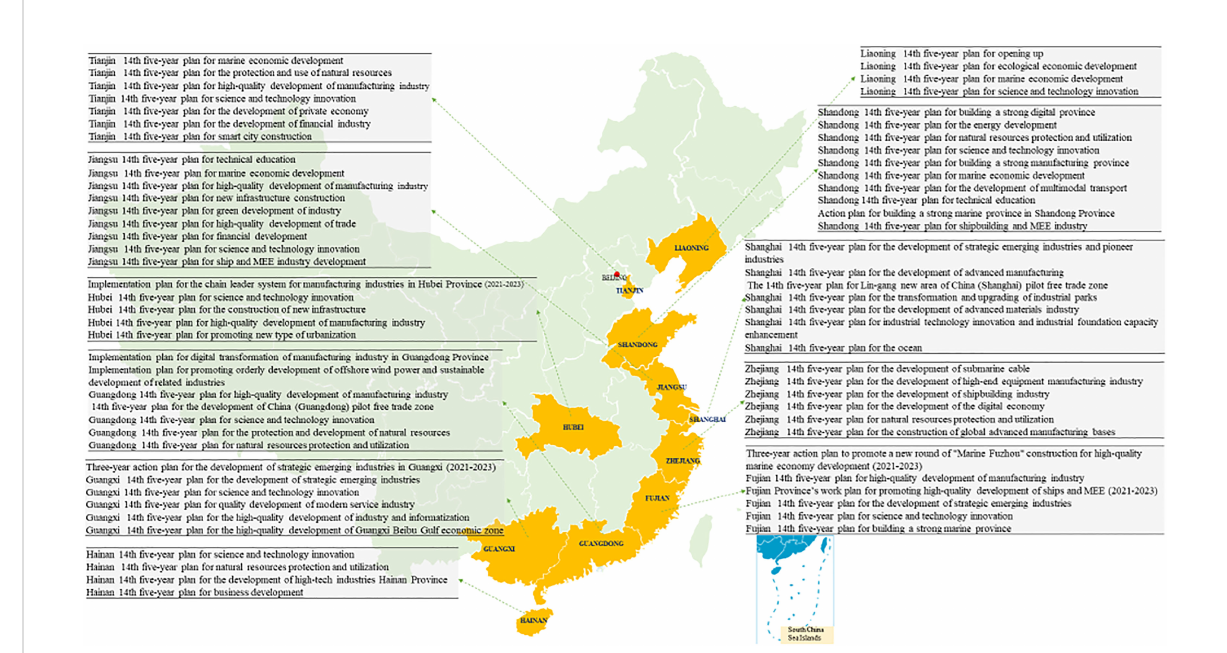
FIGURE 3 Regional governments ’ 14th Five-Year Plans for the MEE industry. Source: Authors ’ compilation.